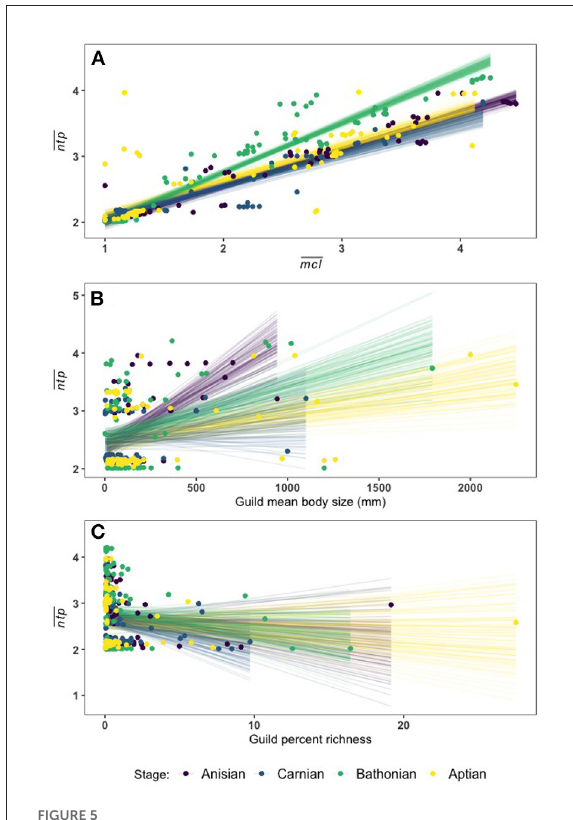
FIGURE5 Linear fit lines from 100 MCMC draws relating ntp to mcl (A) , log bs (B) , and percent guild richness (C) . A full report of posterior distributions for linear model parameters can be found in Supplementary Table 3.